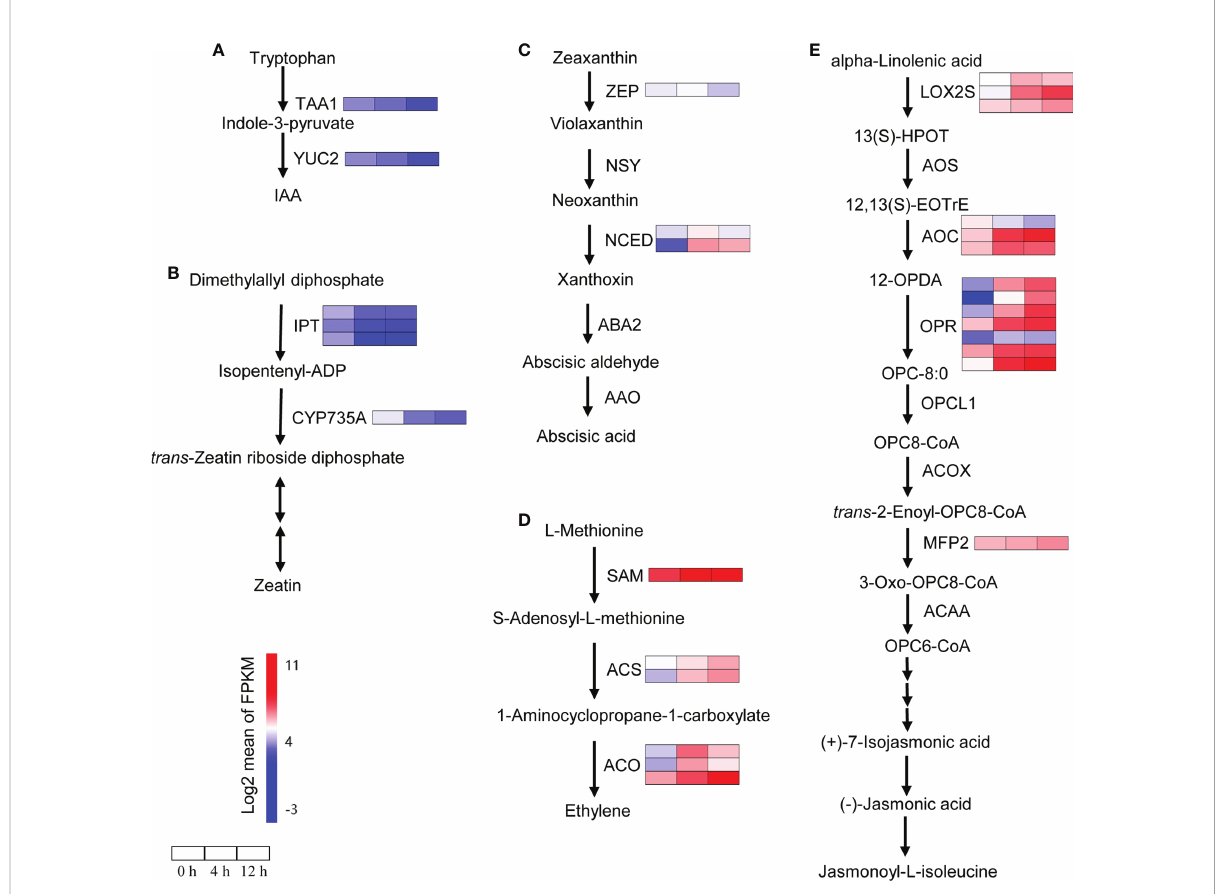
FIGURE 3 Changes in the expression of biosynthetic genes encoding phytohormones after salt stress. (A) Expression analysis of IAA biosynthetic genes. IAA, indole-3-acetic acid; TAA, tryptophan aminotransferase of Arabidopsis; YUC, indole-3-pyruvate monooxygenase 2. (B) Expression analysis of zeatin biosynthetic genes. IPT, isopentenyltransferase; CYP735A, cytokinin trans -hydroxylase. (C) Expression analysis of ABA biosynthetic genes. ABA, abscisic acid; ZEP, zeaxanthin epoxidase; NSY, neoxanthin synthase; NCED, 9- cis -epoxycarotenoid dioxygenase; ABA2, xanthoxin dehydrogenase; AAO, abscisic-aldehyde oxidase. (D) Expression analysis of ethylene biosynthetic genes. SAM, S-adenosylmethionine synthetase; ACS, 1-aminocyclopropane-1-carboxylate synthase; ACO, aminocyclopropanecarboxylate oxidase. (E) Expression analysis of JA biosynthetic genes. LOX2S, lipoxygenase; AOS, hydroperoxide dehydratase; AOC, allene oxide cyclase; OPR, 12-oxophytodienoic acid reductase; OPCL1, OPC-8:0 CoA ligase 1; ACX, acyl-CoA oxidase; MFP2, enoyl-CoA hydratase/3-hydroxyacyl-CoA dehydrogenase 2; ACAA, acetyl-CoA acyltransferase. Genes that changed signi fi cantly at least one time point after salt treatment are shown. Red indicates high expression and blue indicates low